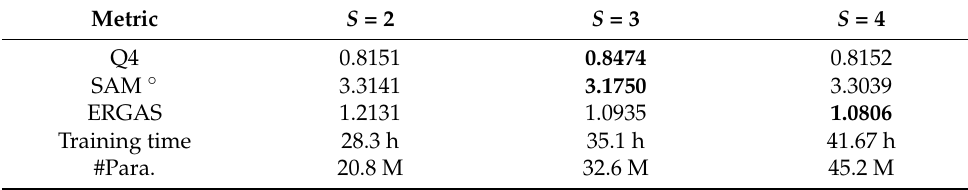
Table 8. Numerical evaluations of the fused images in Figure 12. (GeoEye-1 dataset).